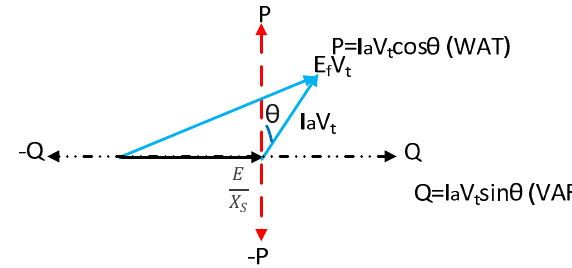
Figure 4. The PV bus capability curve.